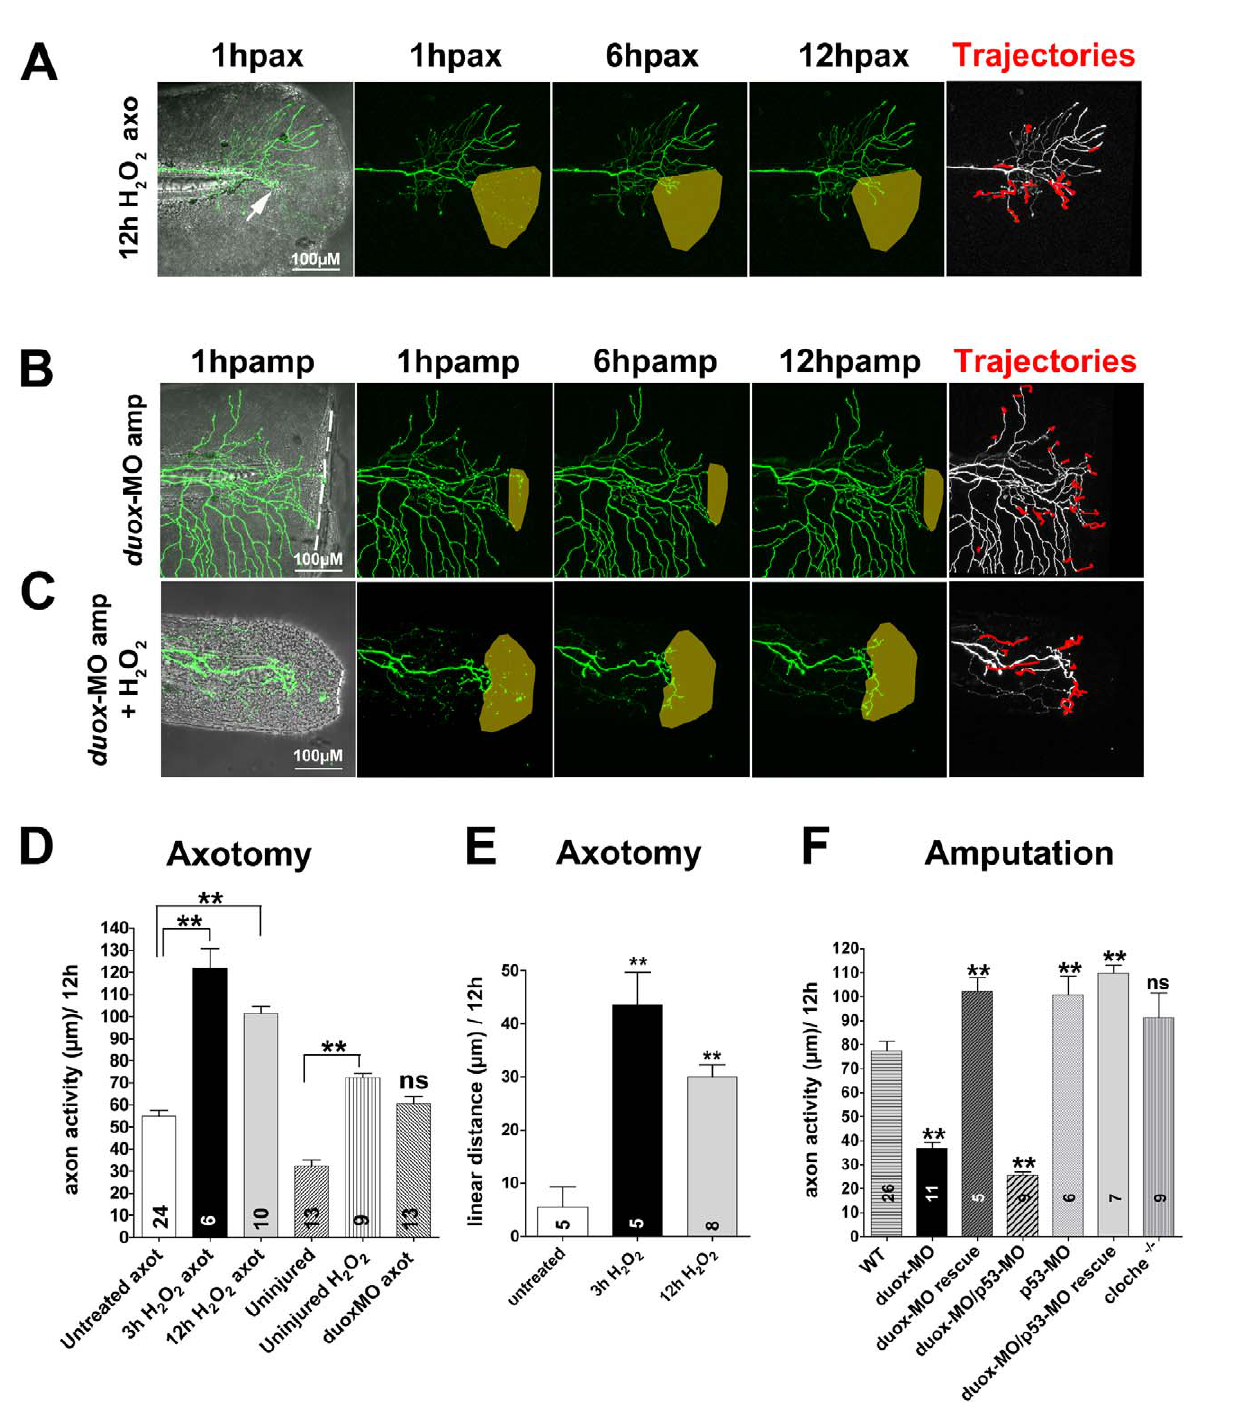
Figure 6. H 2 O 2 promotes peripheral sensory axon growth in the skin. Time-lapse sequences from 78–90 hpf. The rightmost panel shows axon tip trajectories (red) over the course of the time-lapse; denervated territories are indicated by shaded areas. (A) Adding 3 mM H 2 O 2 to the larval media for 12 h enhanced axon growth and promoted reinnervation of denervated territory after axotomy (arrow) in a non-amputated fin (see also Video S6). (B) Fin amputation did not promote axon growth in a duox1 -morphant larva. The axon trajectories reflect mostly tissue movement during the time-lapse (see Video S7). (C) Adding 1.5 mM H 2 O 2 rescued axon growth and improved reinnervation of denervated territory in amputated duox1 - morphants (see also Video S8). (D, E) Quantification of axon activity (D) and linear axon growth (E) after axotomy in larvae treated with H 2 O 2 . (F) Quantification of axon activity after fin amputation. Sample size for each group is indicated by the number in the bar. Error bars represent the standard error of the mean. For statistical analyses, we performed one-way ANOVA and either Dunnett’s post-test to compare individual groups to controls (asterisks above bar indicate significance compared to control, the first column in each graph) or Bonferroni’s post-test to compare individual groups with each other (as indicated by brackets, p = ns . 0.05, ** p , 0.01). axo, axotomy; amp, amputation.